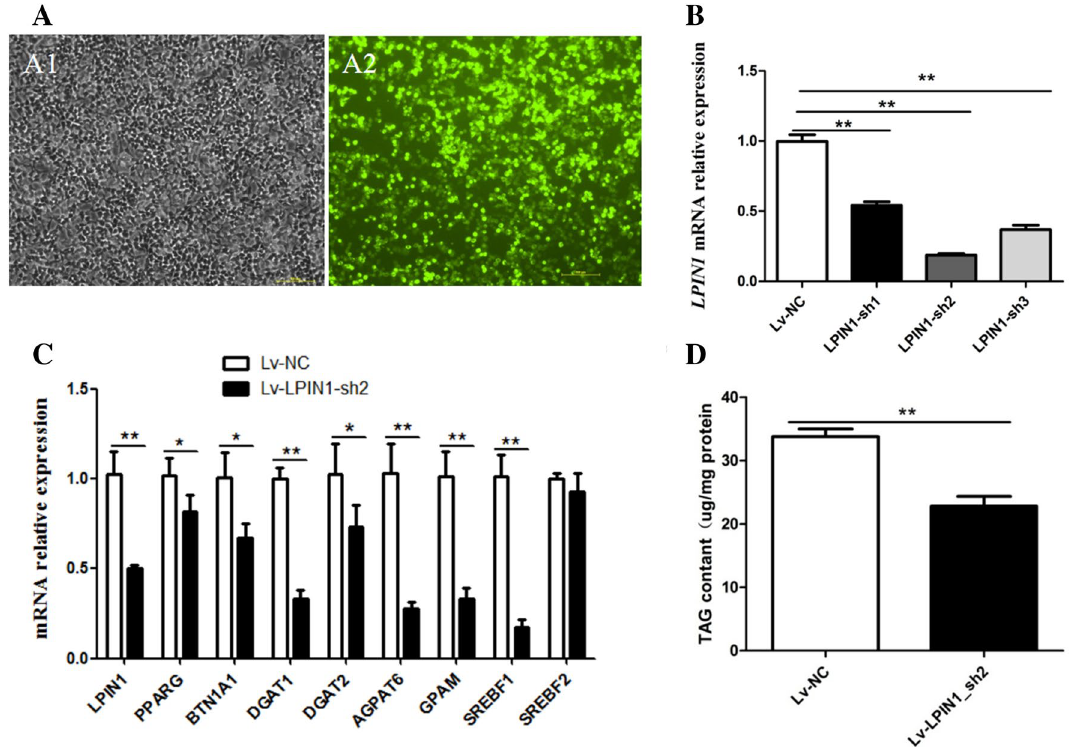
Figure 3. Effect of LPIN1 interference in the BMECs. ( A ) The image of green fluorescence to identify transfection efficiency of shRNAs in HEK-293-T cells; A1. The image of ordinary light of co-transfected with pLKO.1-shRNA and pEGFP-C1-LPIN1; A2. The image of green fluorescence of co-transfected with pLKO.1- shRNA and pEGFP-C1-LPIN1; ( B ) LPIN1 interference efficiency of three shRNA recombinants evaluated via RT-qPCR; ( C ) Interference of LPIN1 down-regulates the expression of genes related to milk fat synthesis in the BMECs; ( D ) The effects of LPIN1 interference on the total cellular TAG content in the BMECs. Values are expressed as means ± SEM for three biological replicates. * P < 0.05; ** P <